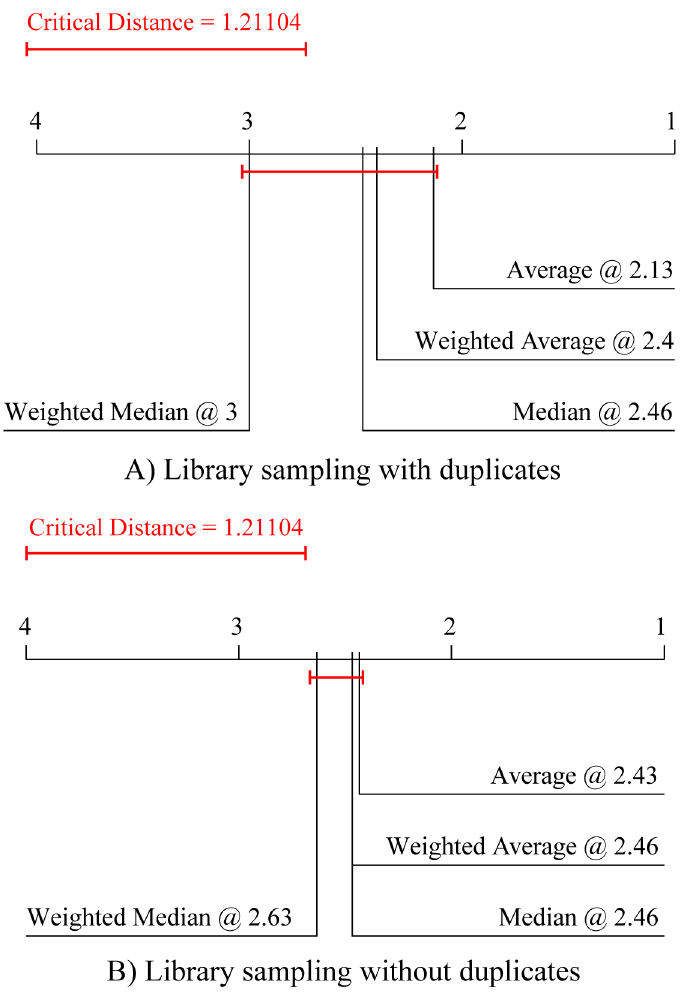
Fig 5. Comparison of the average ranks for predictive performance of the two library sampling methods with four combining methods. Average ranks of the four methods for combining the simulations of base models (average, weighted average, median and weighted median) in terms of predictive performance averaged over the 15 experimental data sets for Library sampling (A) with and (B) without